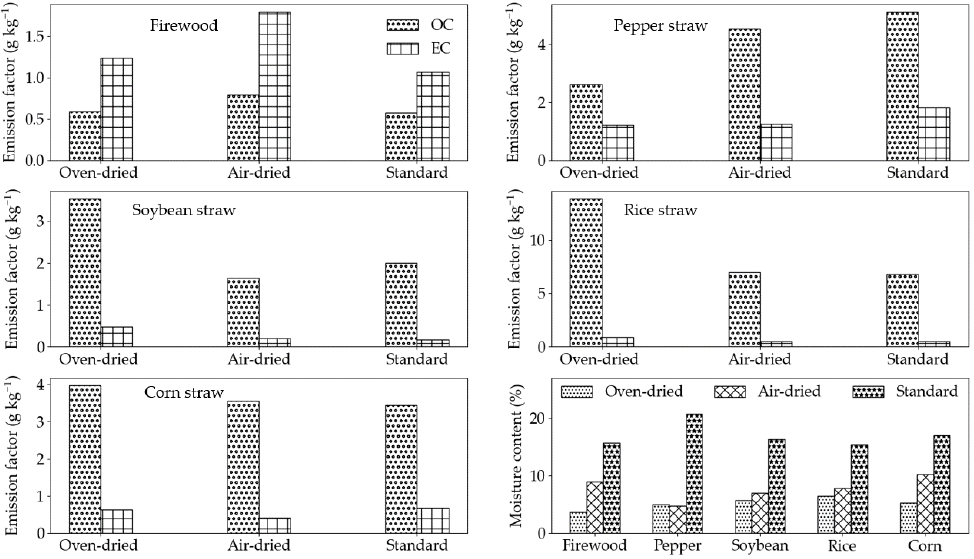
Figure 5. Comparison of OC and EC emission factors among oven-dried, air-dried, and standard